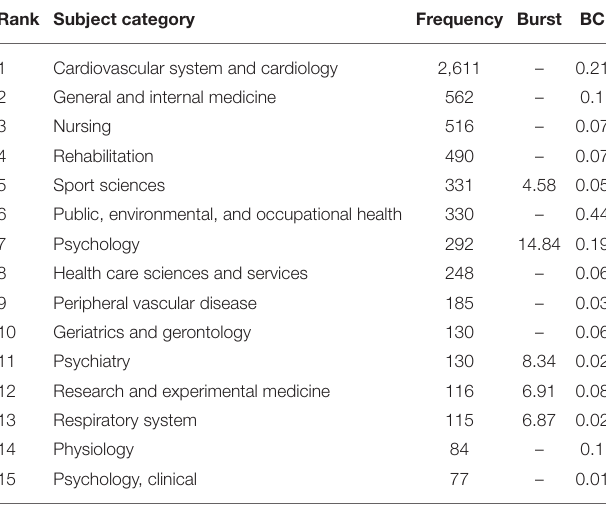
are more impactful disciplines. The red nodes with positive burst detection are popular subjects for a certain period of time. For